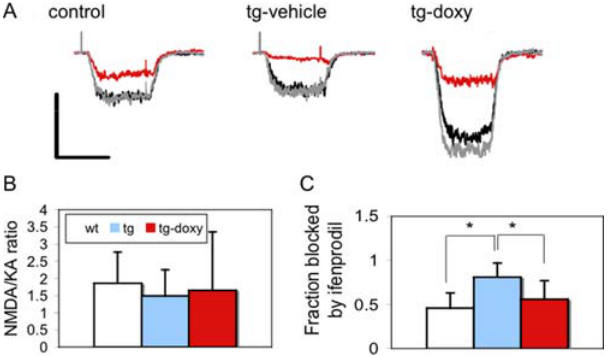
Figure 2. NMDA currents in recombinant NMDAR in cultured granule cells from tg mice. A. Representative current traces elicited by NMDA (300 m M) alone (black lines), NMDA with 10 m M ifenprodil (red line), and after ifenprodil washout (gray line). Application of NMDA